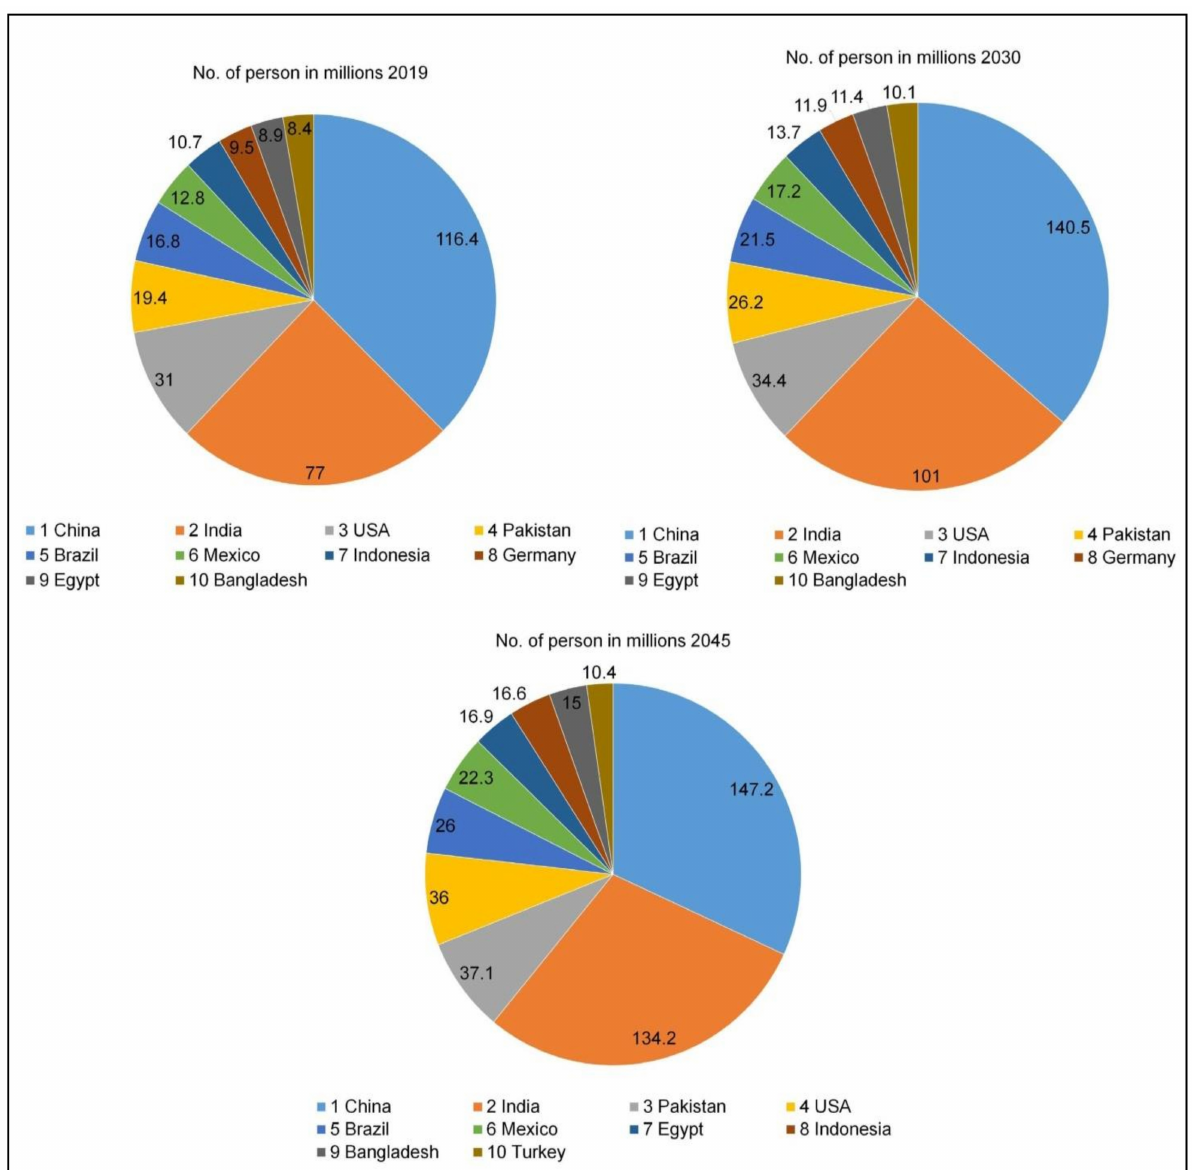
Figure 3. Top 10 countries with the estimated number of diabetic persons in the year 2019, 2030, and